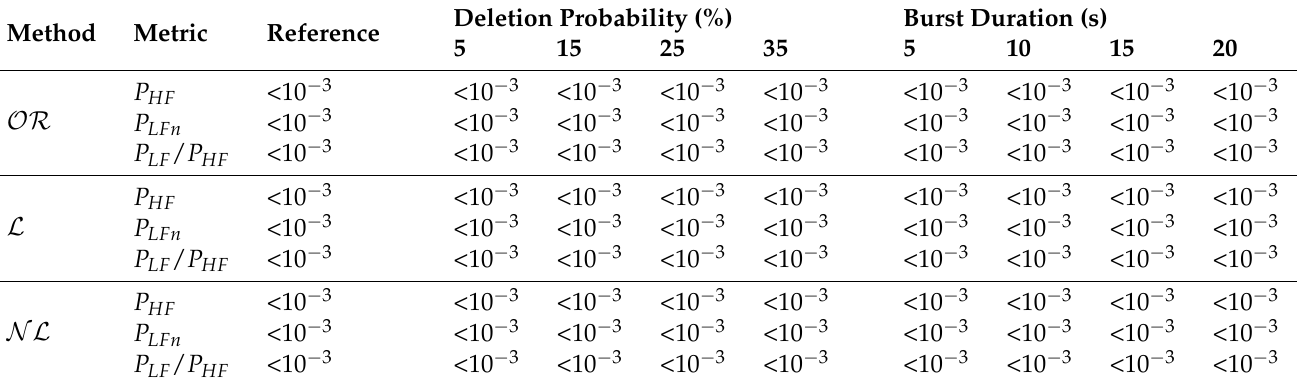
Table 8. p -values of ranked signed test for supine/tilt discrimination of frequency-domain metrics computed via Lomb’s method. N.S.: Not significant ( p > 0.05).